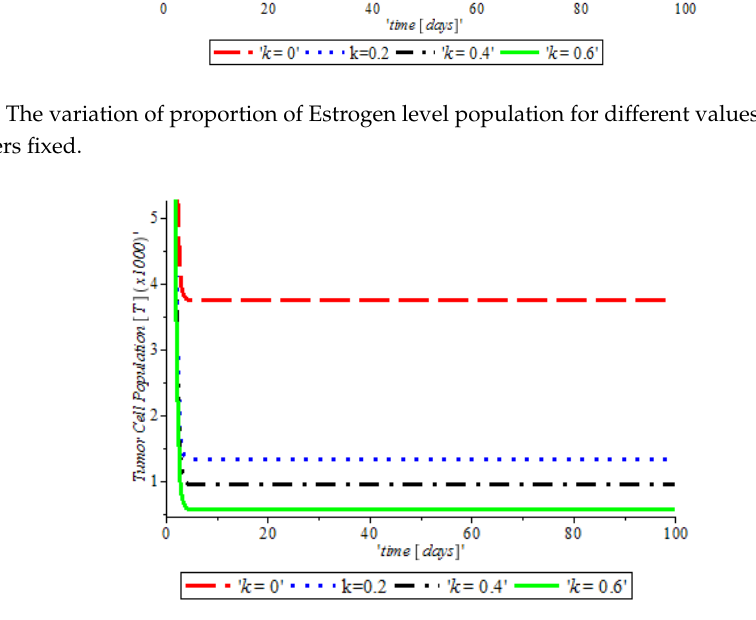
Figure 5. The variation of proportion of Tumor cells population for different values of k with other parameters fixed.